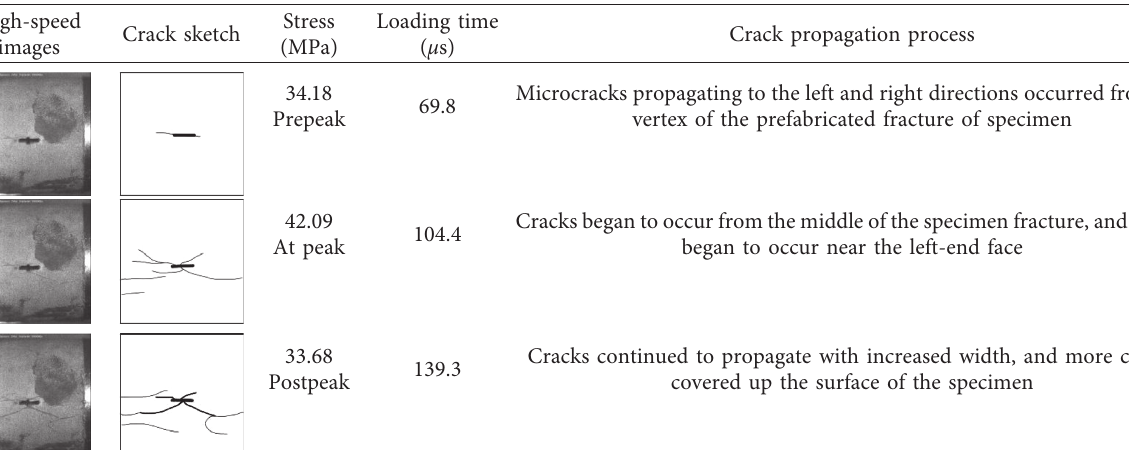
Table 7: Crack propagation process of Specimen b3 at the loading rate of 11.4m/s.